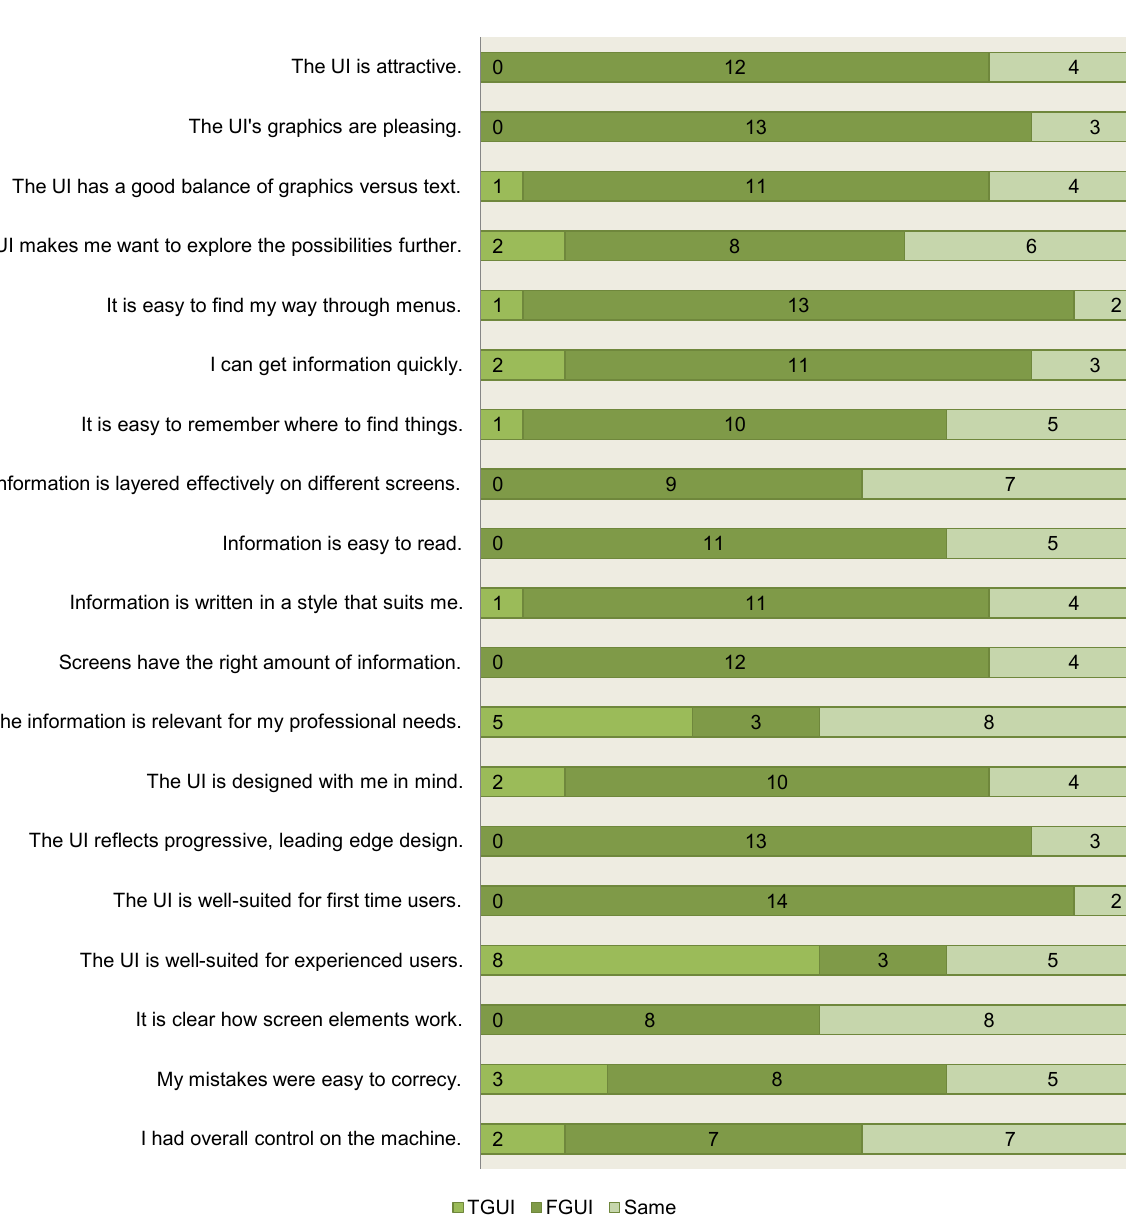
Figure 12: Post-test comparison of TGUI and FGUI in usability features